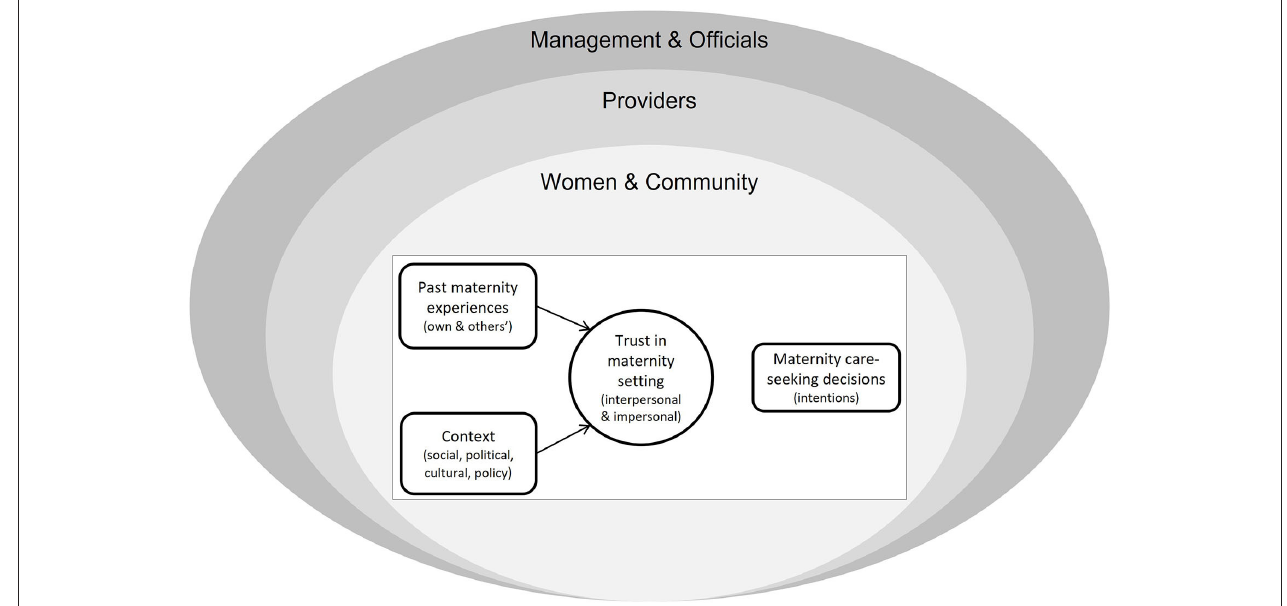
FIGURE 1 | Conceptual